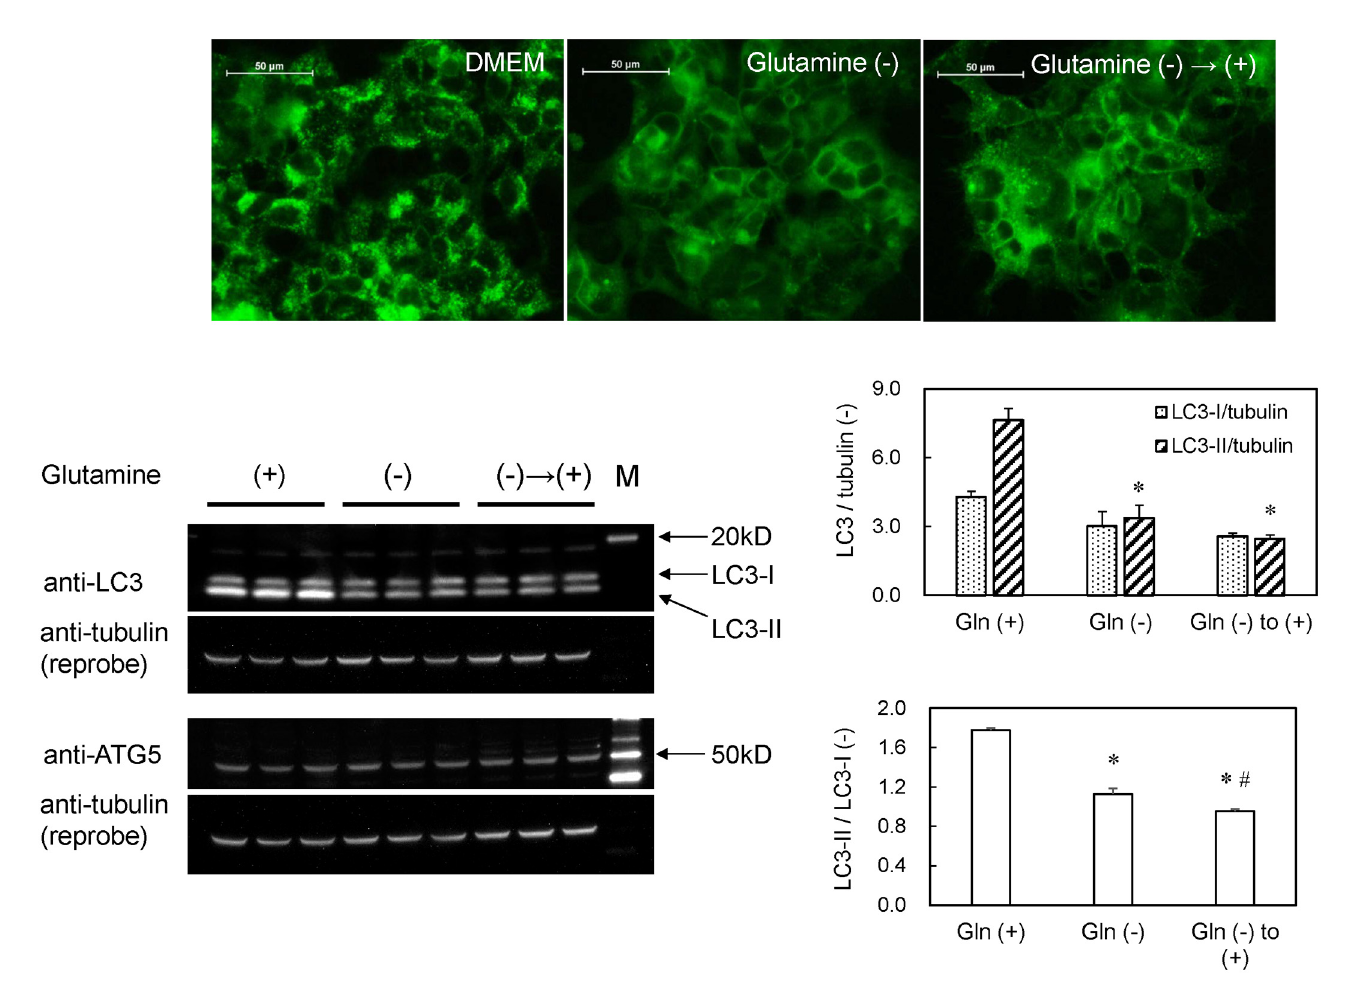
Fig 7. Autophagy in GFP-MARCO-HEK cells is induced by L-glutamine and amines. (A) The cells were cultured (a) in DMEM complete medium for 6 hr; (b) in L-glutamine-free DMEM for 6 hr; or (c) in L-glutamine-free DMEM for 6 hr and then in DMEM (4 mM L-glutamine) for 4 hr. Fluorescent puncta appeared at 4 hr in the presence of 4 mM L-glutamine. The images were captured by fluorescence microscopy. (B) Western blot analysis of LC3 and ATG5 in GFP-MARCO-HEK cells. The cells were cultured in complete DMEM (4 mM L-glutamine) (left three lanes), L-glutamine-free DMEM for 6 hr (middle three lanes), or L-glutamine-free DMEM for 6 hr followed by culturing in complete DMEM (4 mM L-glutamine) (right three lanes). M, Western marker lane. α -Tubulin was adopted as loading control and the amount of LC3-I, LC3-II and tubulin were measured by densitometry. LC3-I/tubulin, LC3-II/tubulin, and LC3-II/LC3-I ratios were presented as mean ± SEM (N = 3). * , Significantly different from glutamine (+). #, Significantly different from glutamine